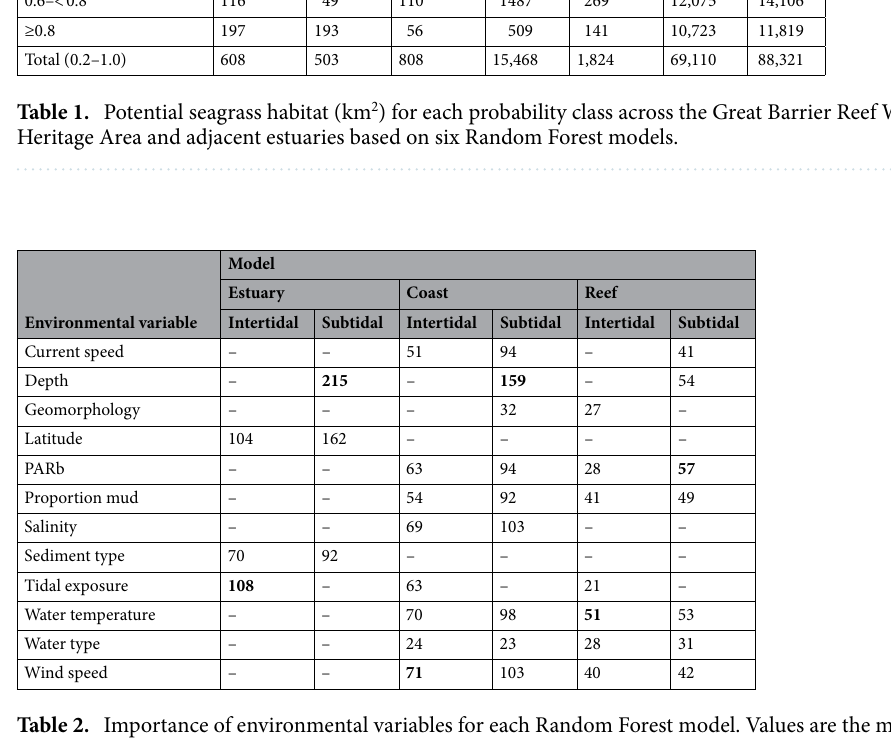
Table 2. Importance of environmental variables for each Random Forest model. Values are the mean decrease of accuracy in predictions on the out-of-bag samples when a given variable is excluded from the model. The most important variable is in bold. “–” indicates variable not included in